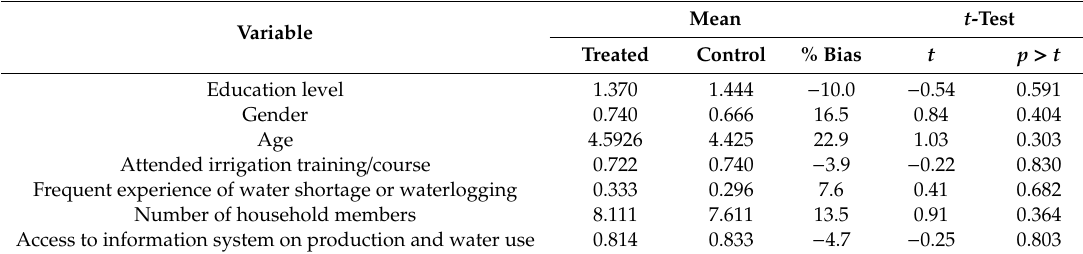
Table 4. Balancing t -test after propensity score matching.